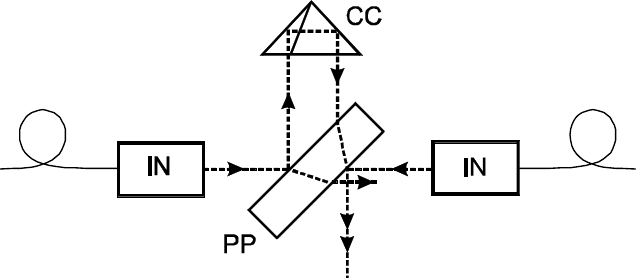
Figure 5. Alignment configuration for parallelism of two couterpropagating